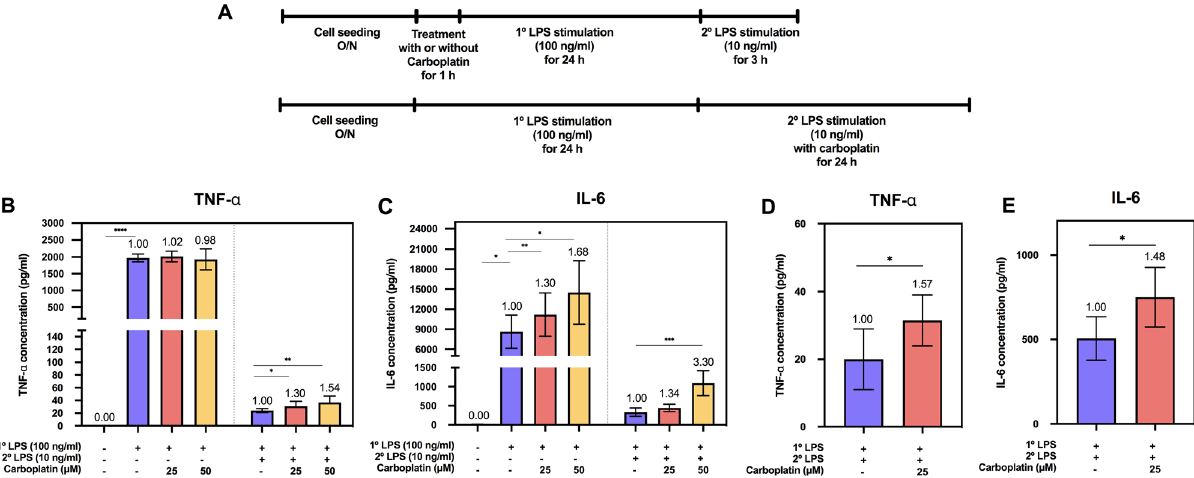
Figure 1. Effect of carboplatin on TNF-α and IL-6 production in LPS-primed and LPS-tolerant macrophages. ( A ) Schematic of the procedures for carboplatin and LPS treatment. BMDMs were pretreated with or without carboplatin (25 or 50 μM) for 1 h prior to LPS priming (1°LPS; 100 ng/ml) for 24 h. After 24 h incubation, cells were challenged with LPS (2°LPS; 10 ng/ml) for 3 h (upper panel) or 24 h (lower panel). ( B – E ) TNF-α ( B , D ) and IL-6 ( C , E ) production after 3 h or 24 h of incubation was measured by ELISA. Data are representative of at least 3 independent experiments. *, **, ***, **** indicate p < 0.05, p < 0.01, p < 0.001, p < 0.0001, respectively, using one-way ANOVA. The numbers above the bars indicate fold differences compared to those without